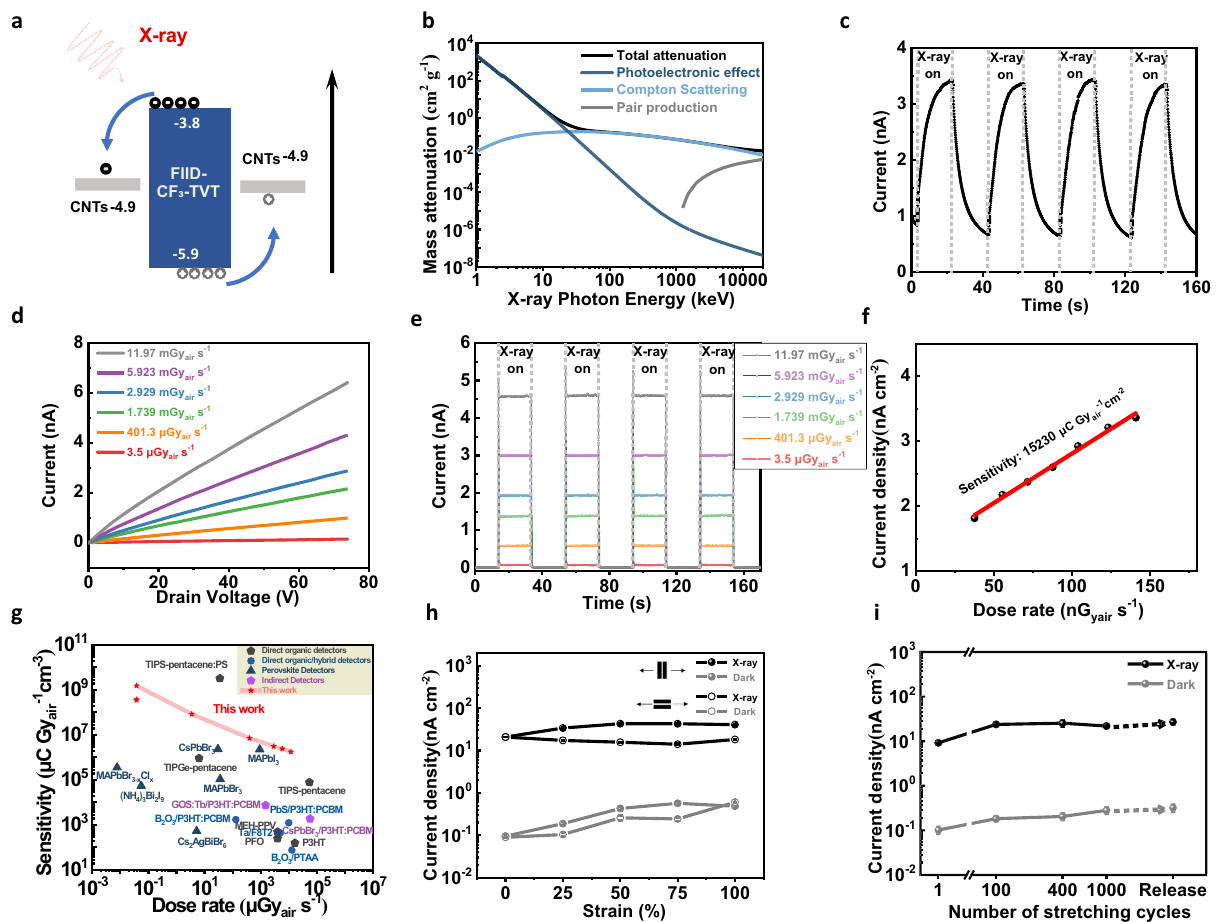
Fig. 3 | Intrinsically stretchable X-ray detectors fabricated using the n-type semiconductor fi lms. a The energy level diagrams of CNT electrodes and FIID- CF 3 TVT semiconductor for X-ray detectors. b Total mass attenuation of X-rays by FIID-CF 3 TVT hybrid polymer semiconductor with 70wt% SEBS showing the con- tribution from photoelectric effect, compton scattering, and pair production. c Temporal response of neat FIID-CF 3 TVT fi lms to X-ray upon turning the X-ray source on and off under 3.5 μ Gy air s − 1 dose rates. d Typical I – V DS curves of OCSC n-type hybrid semiconductor fi lms under different dose rates at V G =0V. e Device response of OCSC n-type hybrid polymer semiconductor fi lms to X-ray upon turning the X-ray source on and off under different dose rates at V DS =60V ( V G = 0V). f X-ray photocurrent density as a function of X-ray dose rate at V DS =60V ( V G =0V) under serval dose rates from 37.7 to 141nGy air s − 1 . g Performance com- parison including the sensitivity ( S V ) and detection limit of current reported X-ray